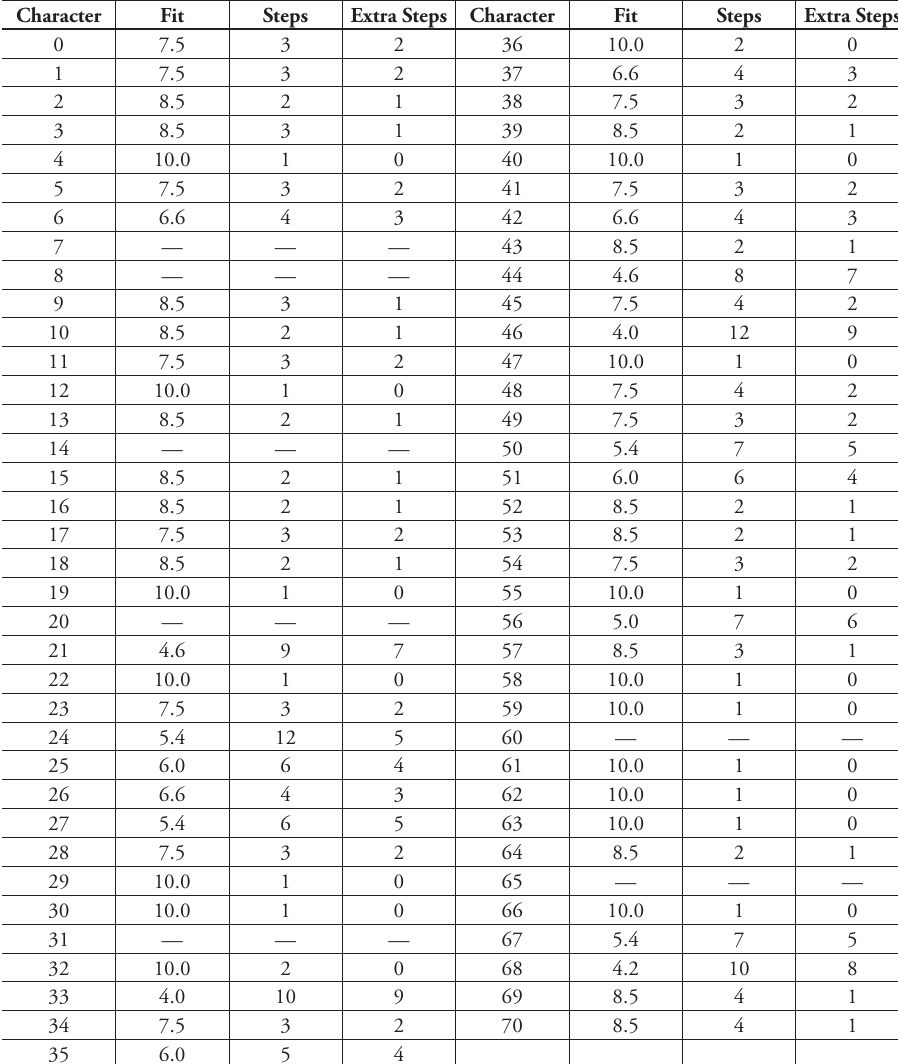
Table 5. Fits, Steps and Extra Steps for characters of cladogram of Fig